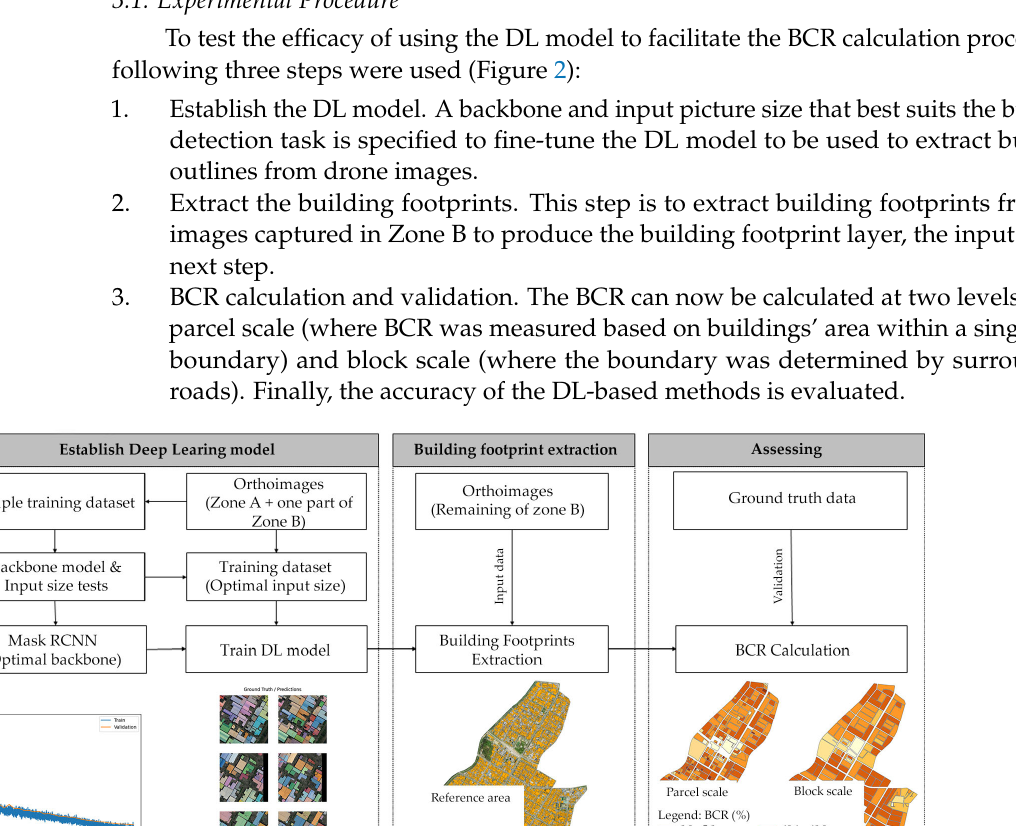
Figure 1. Zone A and Zone B (within the red boundaries) of the Sihwa industrial complex.